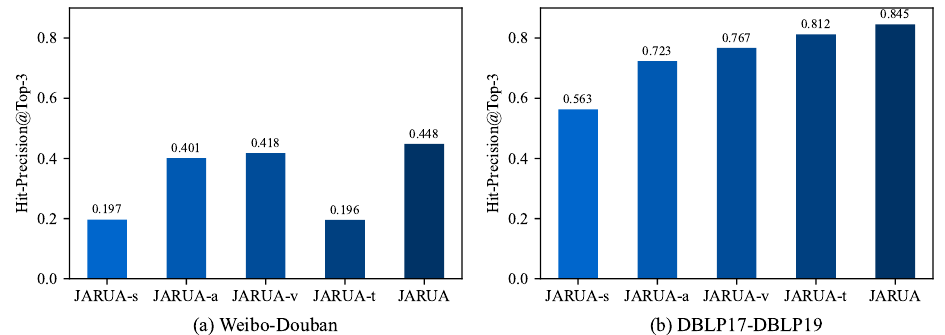
Figure 5. Hit-Precision scores of JARUA’s variants on ( a ) social networks, ( b ) coauthor